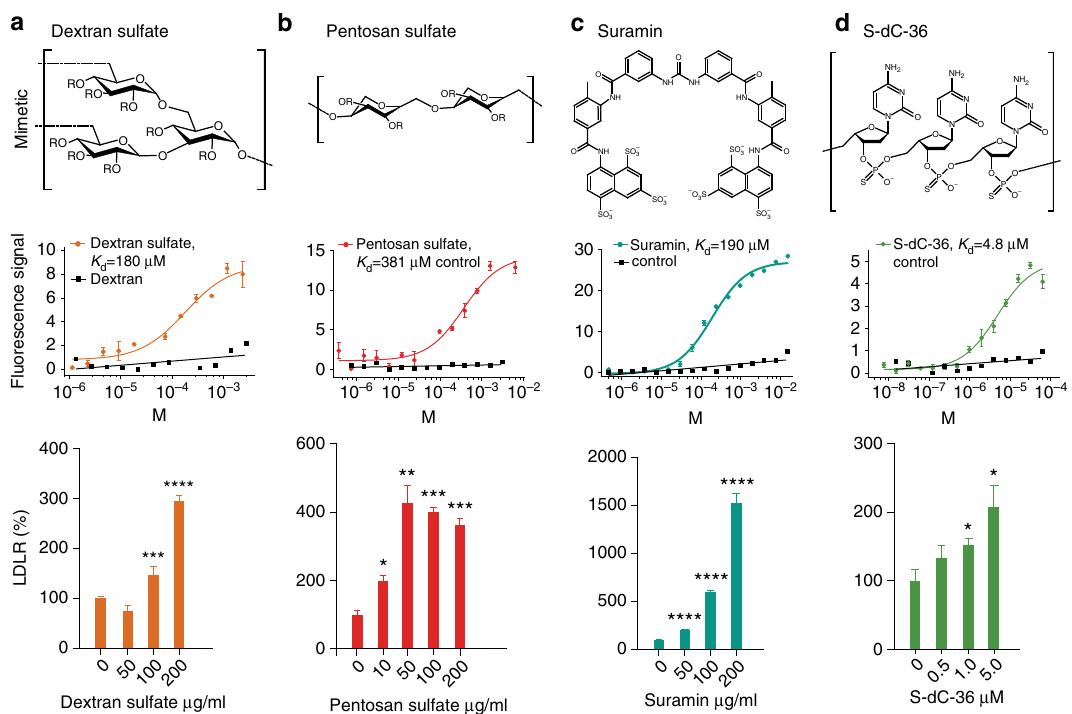
Fig. 2 Heparin mimetics are potent PCSK9 inhibitors. Structure of the heparin mimetics dextran sulfate ( a ), pentosan sulfate ( b ), suramin ( c ), and the phosphorothioate oligonucleotide S-dC-36 ( d ) (R = SO 3 − or H). Binding curves and the dose-dependent effects on LDLR levels in HepG2 cells ( n = 3 – 5, bar graphs show mean values with s.e.m. error bars) are shown below each mimetic structure. Statistical signi fi cance was evaluated using a two-tailed Student ’ s t -test. Summary of binding constants and representative LDLR Western blots are shown in Supplementary Fig. 5d,